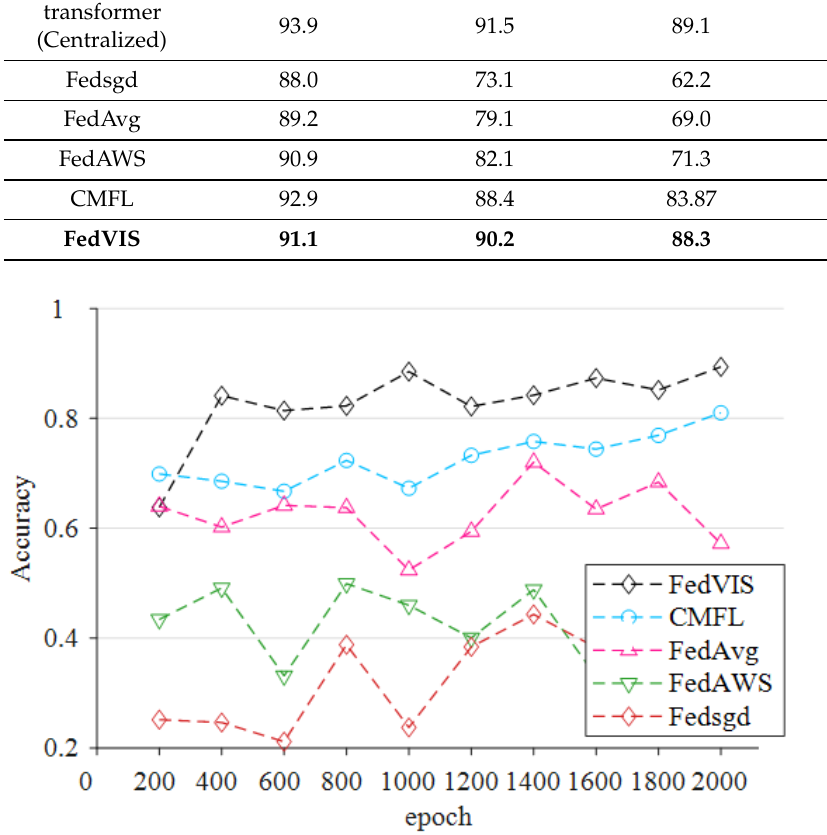
Figure 7. Test result. Accuracy vs. Epoch Graph on the testing dataset with different methods. As the epoch increases, FedVIS is at the top compared to other federation learning algorithms which indicates that FedVIS was able to learn and predict quite